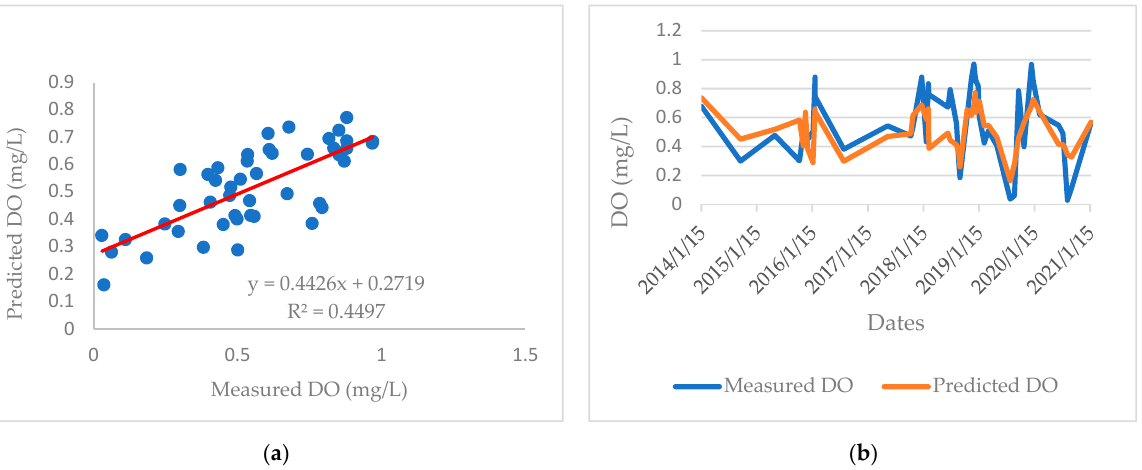
Figure 5. Comparison between experimental DO data and those obtained by the proposed MLR model. ( a ) Correlation between measured and predicted DO; ( b ) Date profile of measured and predicted DO.